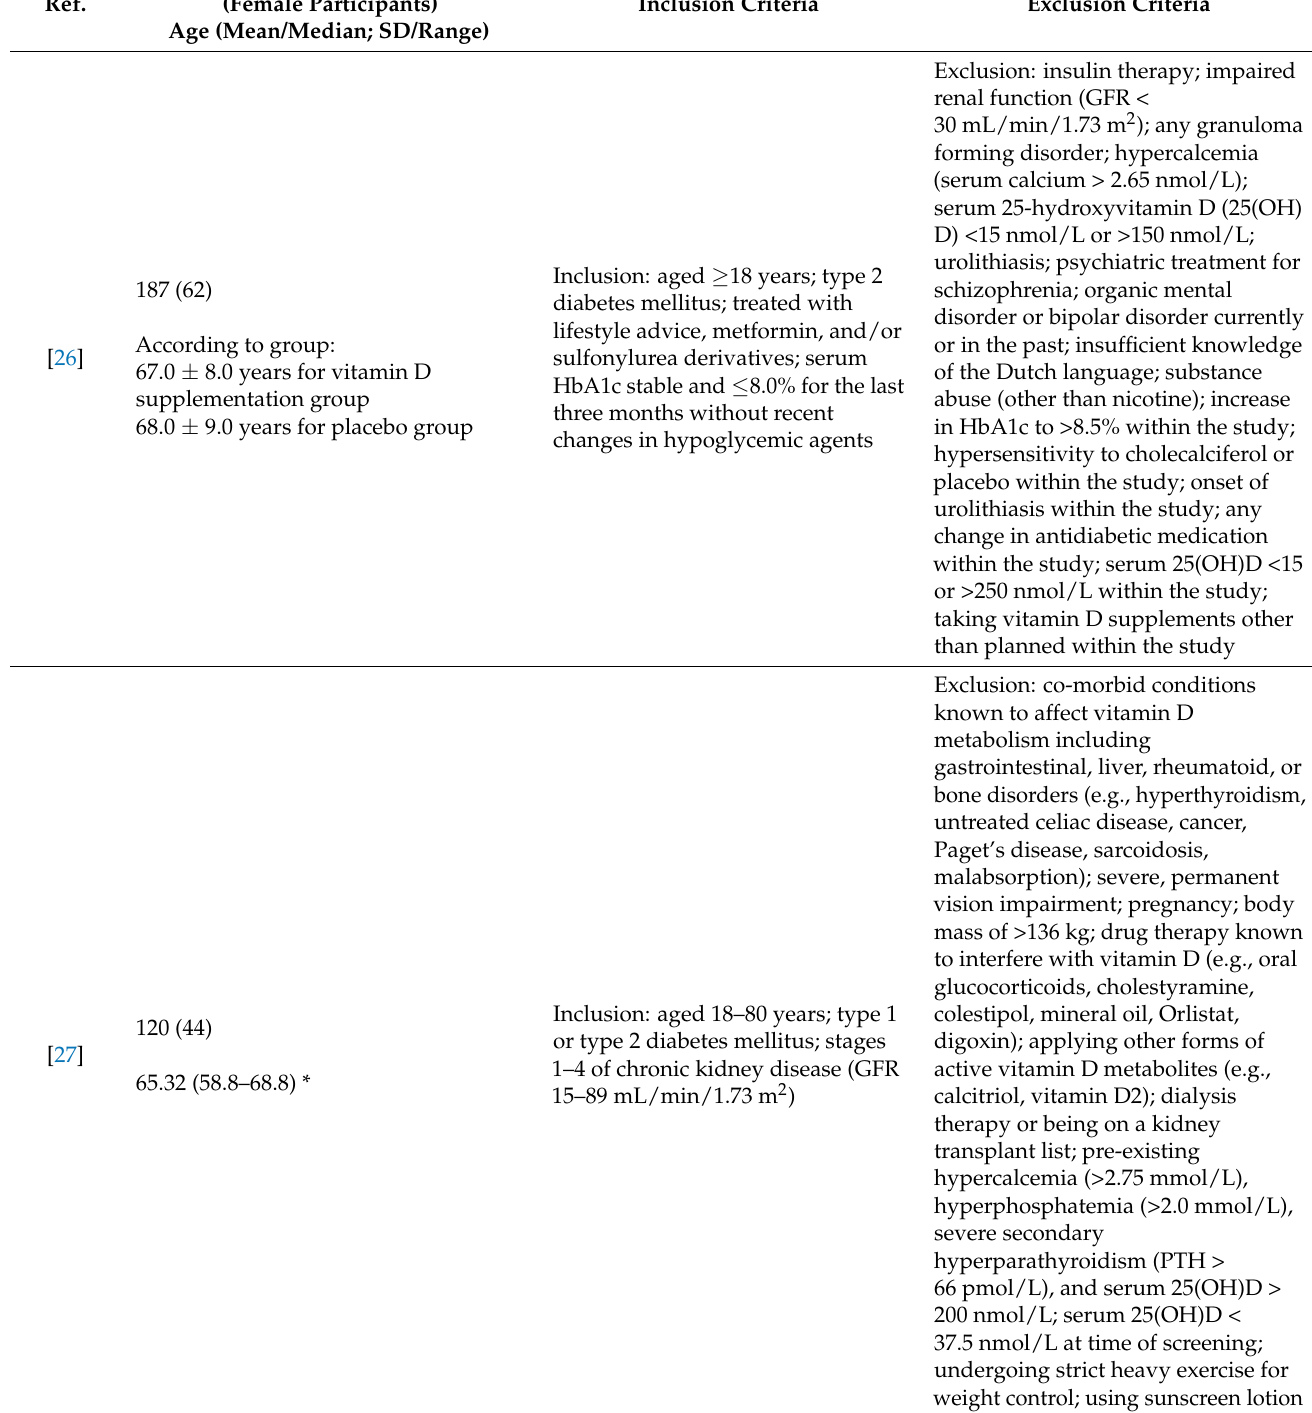
Table 3. The basic characteristics of the participants of the studies included in the systematic review.